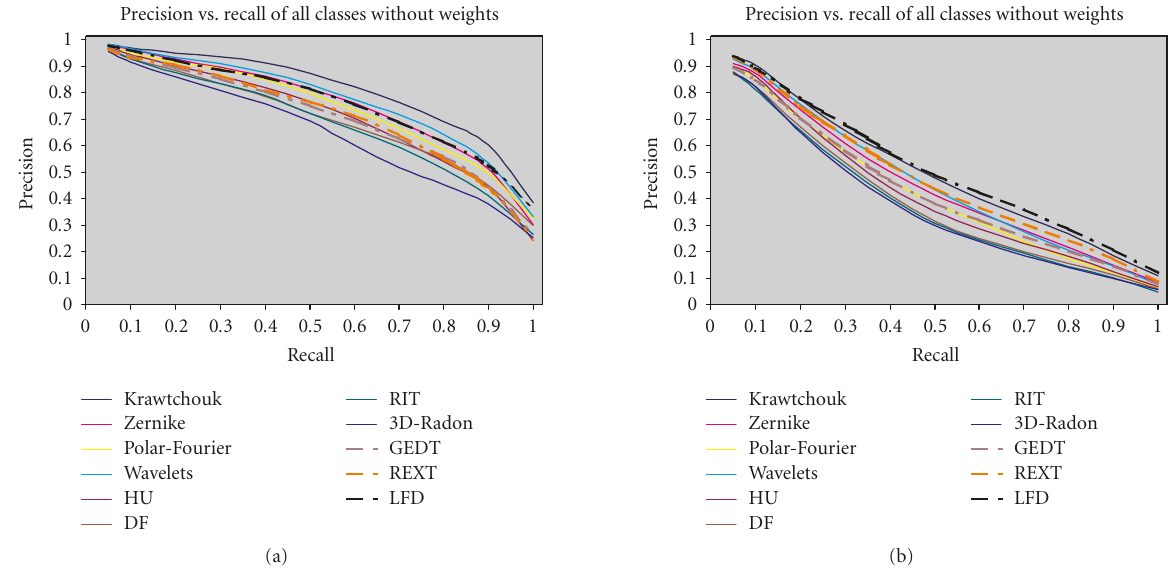
Figure 4: Precision-recall curves diagram using the new database (a) and the Princeton database